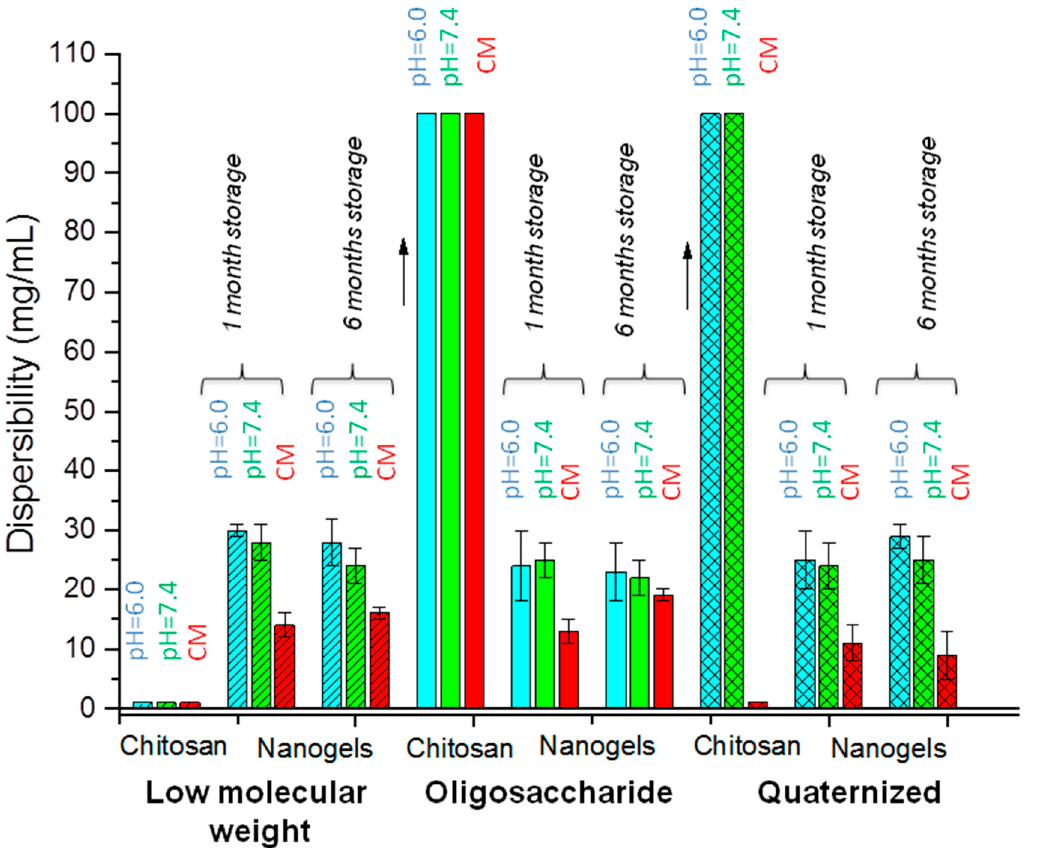
Figure 10. The estimated solubility of the pristine chitosans and the dispersibility of the synthesized nanogels in different media (water pH = 6.0, water pH = 7.4, and culture medium (CM)) for a 1- and 6-month storage period.